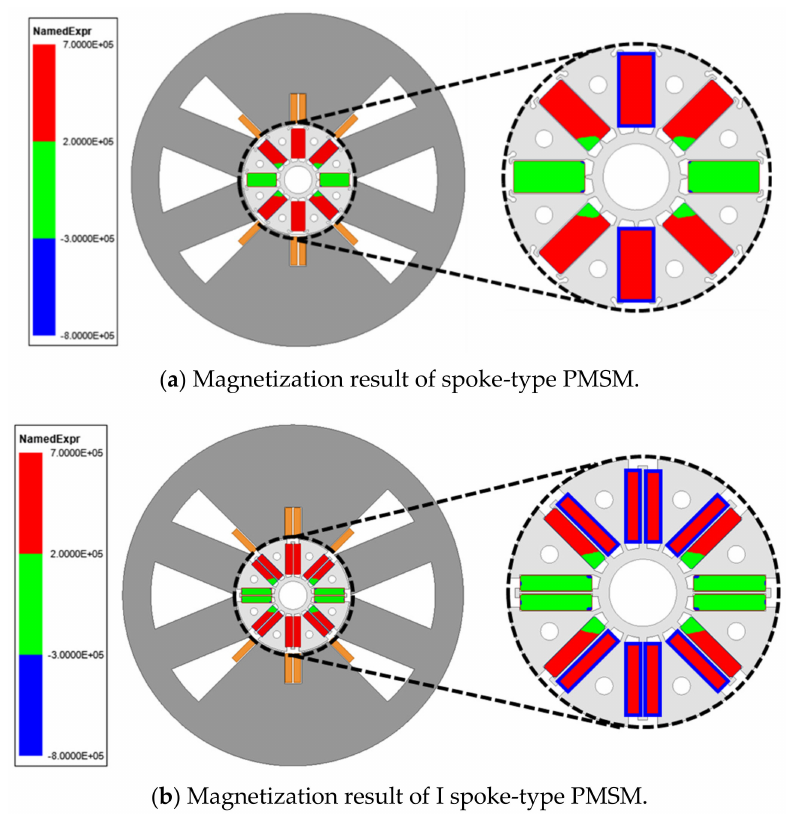
Figure 20. Compare of two types of magnetization